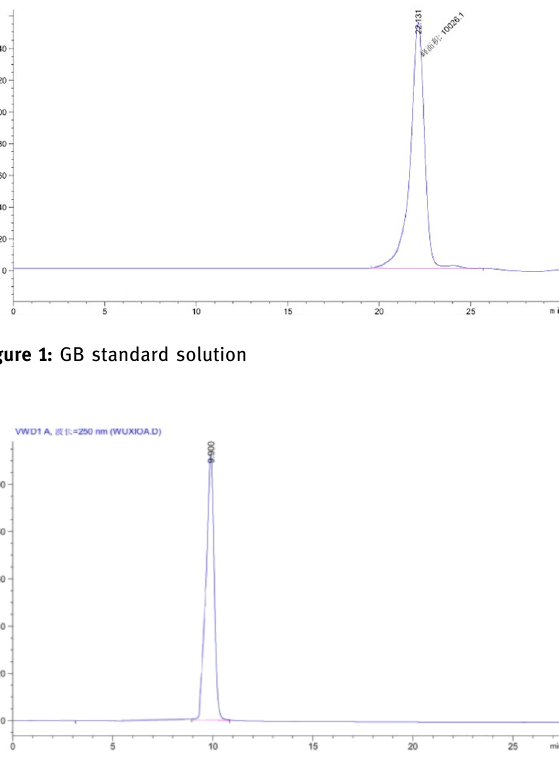
Figure 2: Pue standard solution